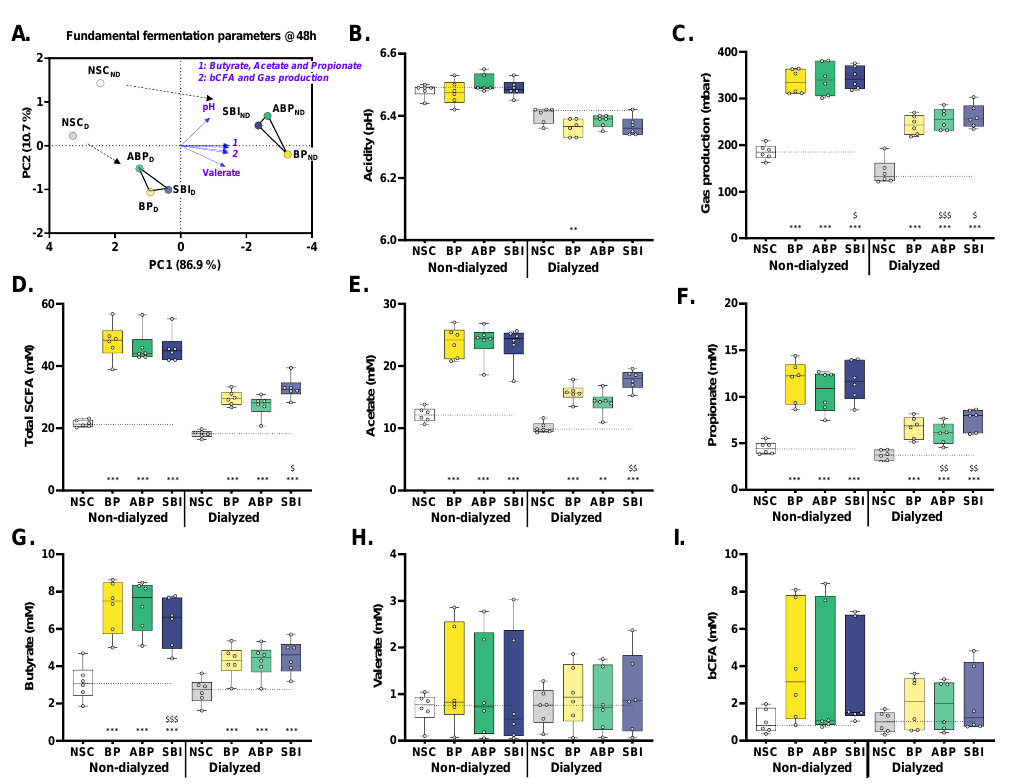
Figure 5. Three bovine plasma protein fractions (BP, ABP and SBI), particularly SBI, boosted production of health-related SCFA by human adult gut microbes ex vivo. ( A ) PCA analysis based on the standardized average values across donors ( n = 6) for fundamental fermentation parameters (pH, gas production, acetate, propionate, butyrate, valerate and bCFA) upon treatment with three bovine plasma protein fractions (BP/ABP/SBI), dosed at an equivalent of 5 g/day, with or without prior dialysis as a simulation of small intestinal absorption, compared to a NSC, as tested via the SIFR ® technology. The impact on ( B ) pH, ( C ) gas production, ( D ) total SCFA, ( E ) acetate, ( F ) propionate, ( G ) butyrate, ( H ) valerate and ( I ) bCFA for all test products compared to the NSC. Statistical differences between treatments and the NSC are indicated with ** (0.001 < p < 0.01) or *** ( p < 0.001), while differences between protein fractions ABP/SBI and fraction BP are indicated with $/$$/$$$. BP = bovine plasma, ABP = albumin-enriched bovine plasma, SBI = serum-derived bovine immunoglobulin, PCA = principal component analysis, SIFR = systemic intestinal fermentation research, NSC = no substrate control, SCFA = short-chain fatty acid, and bCFA = branched-chain fatty acid.